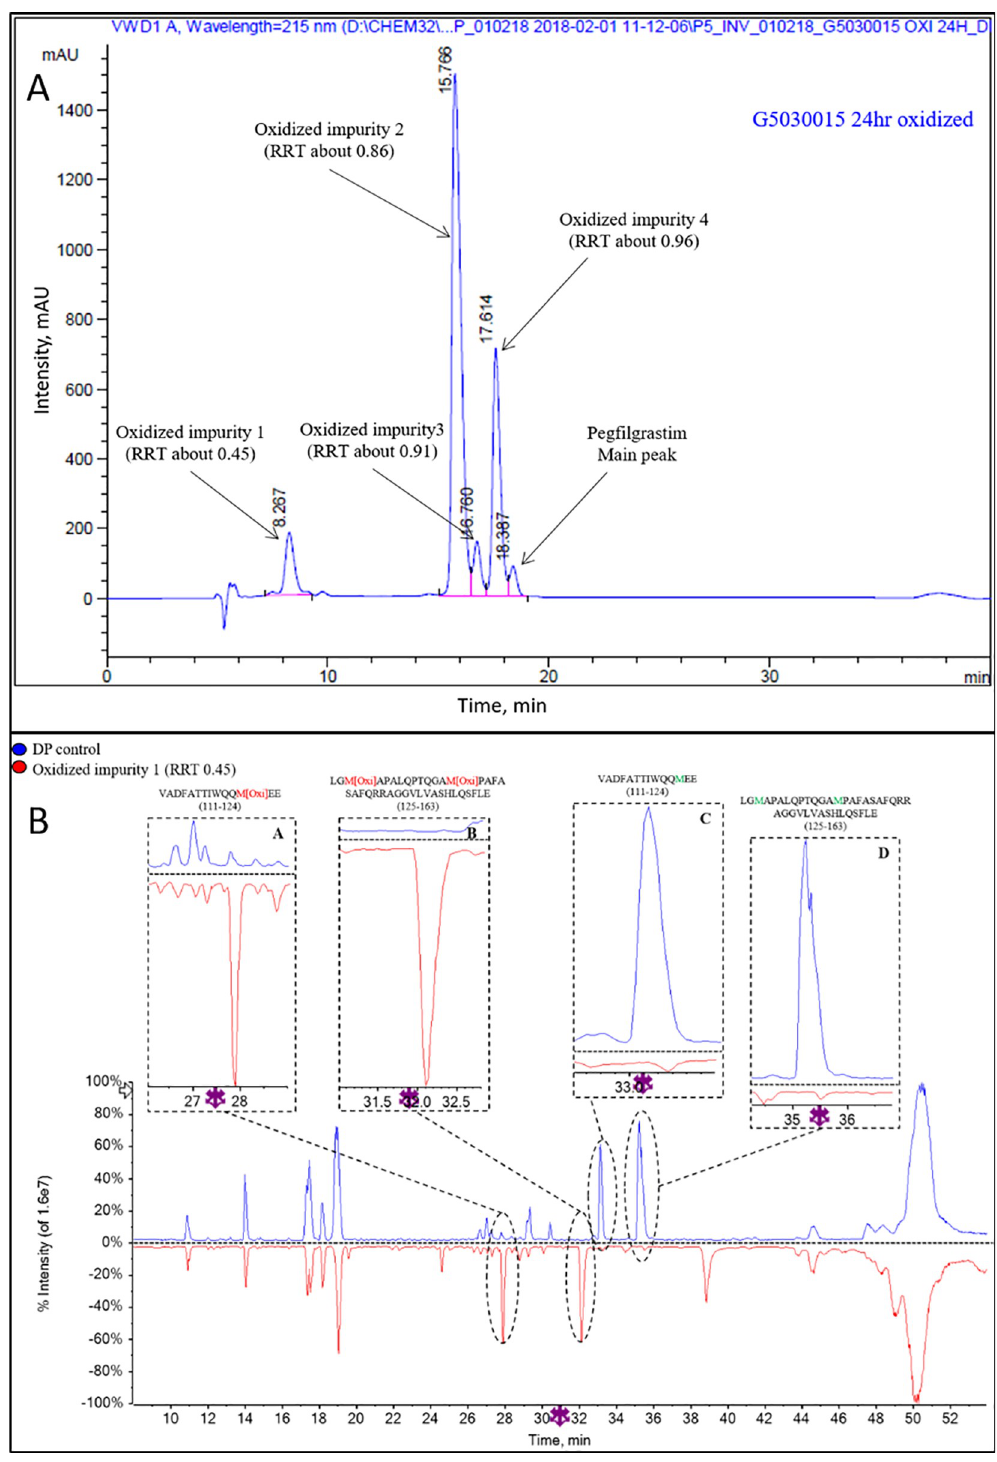
Fig 12. (A) Representative RP-HPLC profile of oxidized (24 hours) INTP5 Sample I2 (B) Overlay of control sample and oxidized impurity 1 (RRT About 0.45) TIC of peptide mapping (10–54 min).